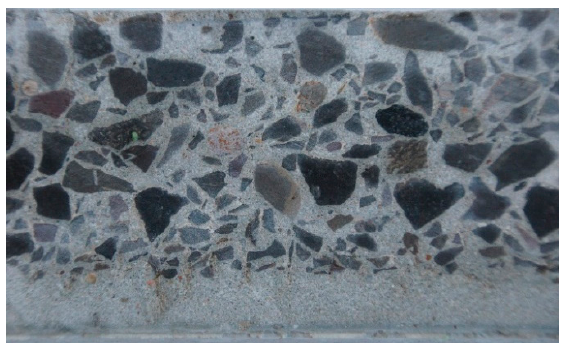
Figure 1. The structure of spun concrete in the wall thickness of a power pole.